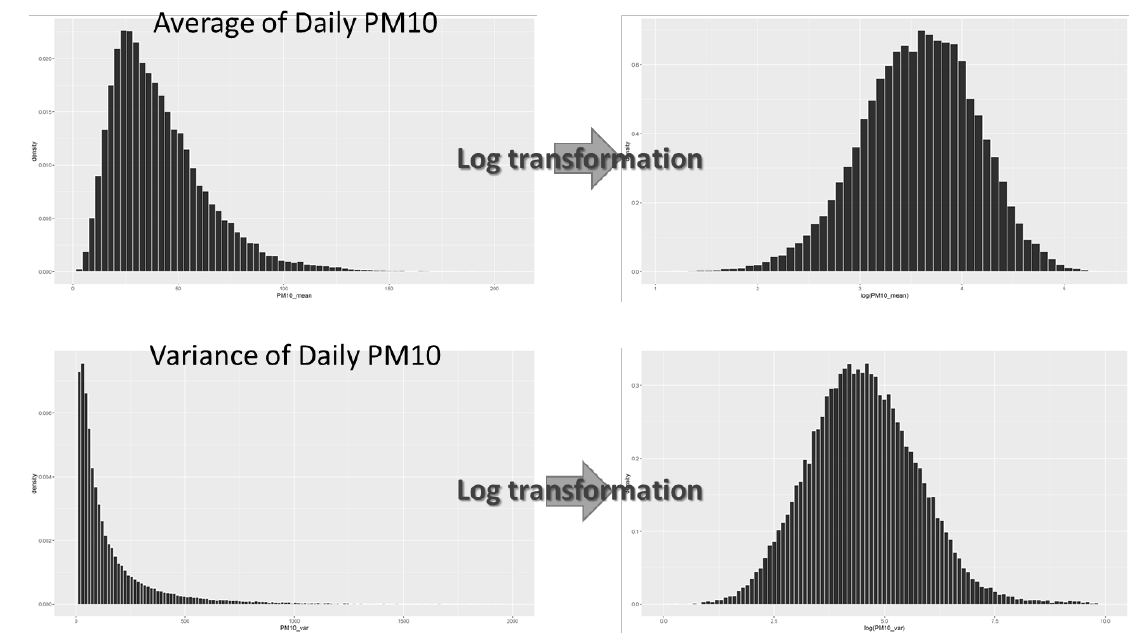
Figure 3. Distribution of dependent variables and log transformation. The dependent variables in the two models were the daily mean concentrations and variability of PM10. The explanatory variables were composed of land use, seasonal, and macro or microclimate features. Furthermore, a region dummy was added as a control variable to reflect the characteristics of each city that are difficult to explain with the inde- pendent variables (Table 2). Table 2. Variables of the log-lin models.